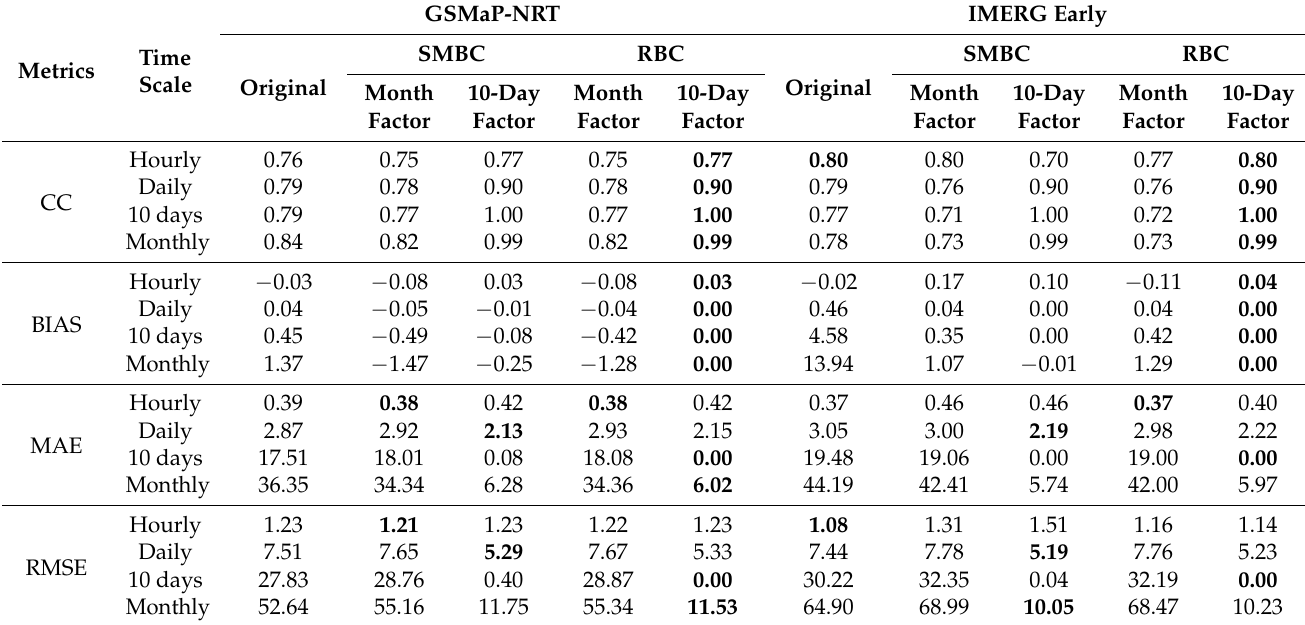
Table 1. Evaluation criteria for the NRT-SPPs over the Fuji River basin of various temporal scales. The bold values represent the highest recorded performance for each SPPs at each temporal scale.